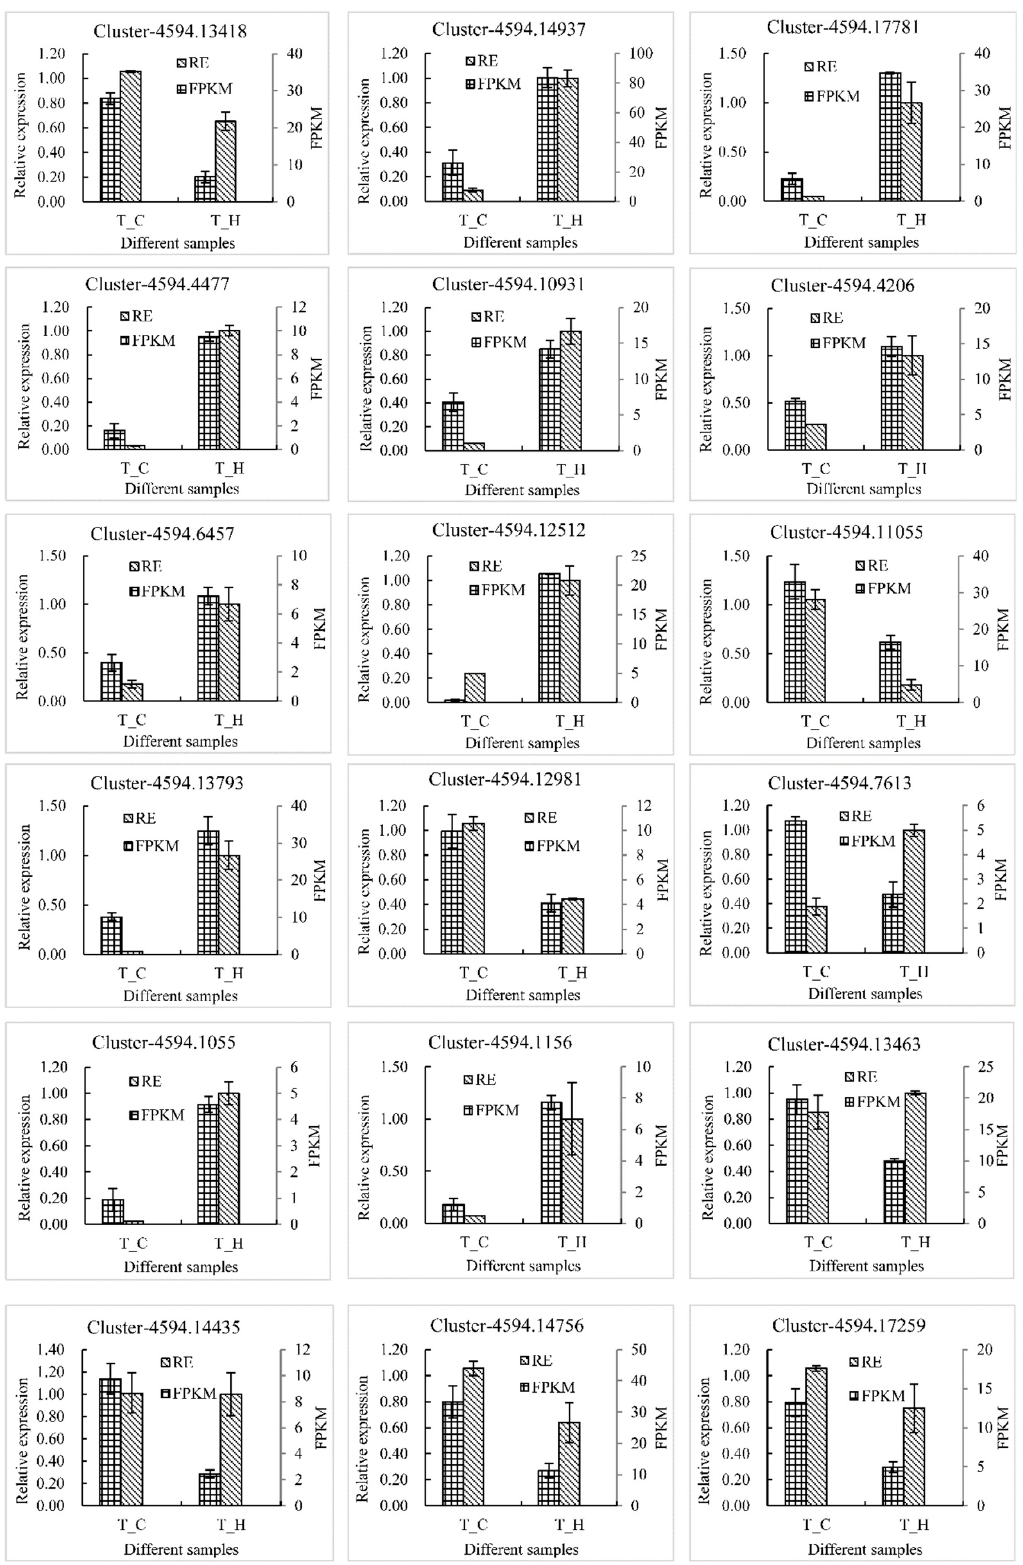
Figure 6. qRT-PCR verification of candidate genes related to flavonoid synthesis. RE and FPKM respectively represent the relative expression and fragments per kilobase million of each gene in